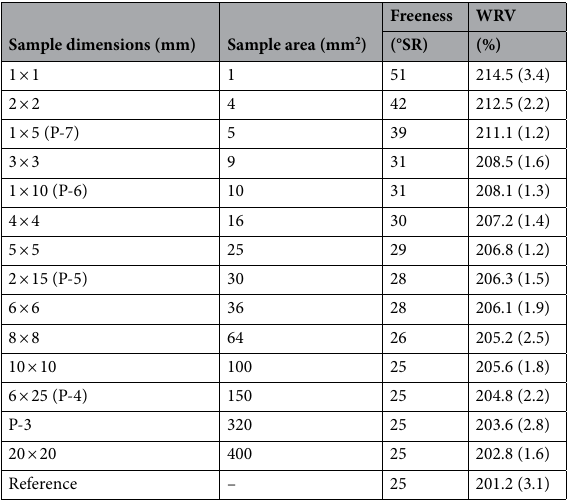
Table 2. Characteristics of refined cellulose pulps. Standard deviation are given in